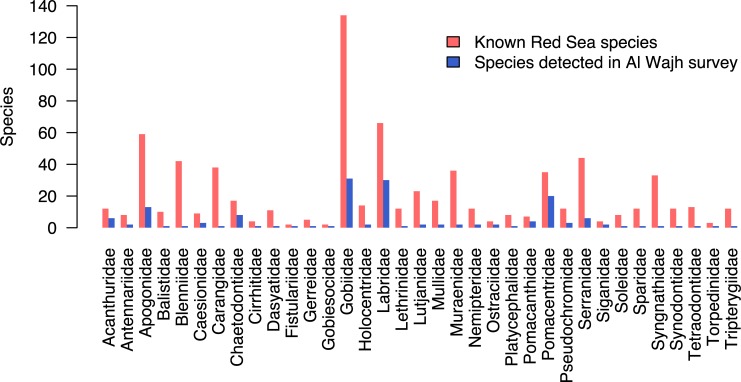
Comparison of species diversity in each fish family for both survey methods against known species in the Red Sea based on Golani and Fricke [43].